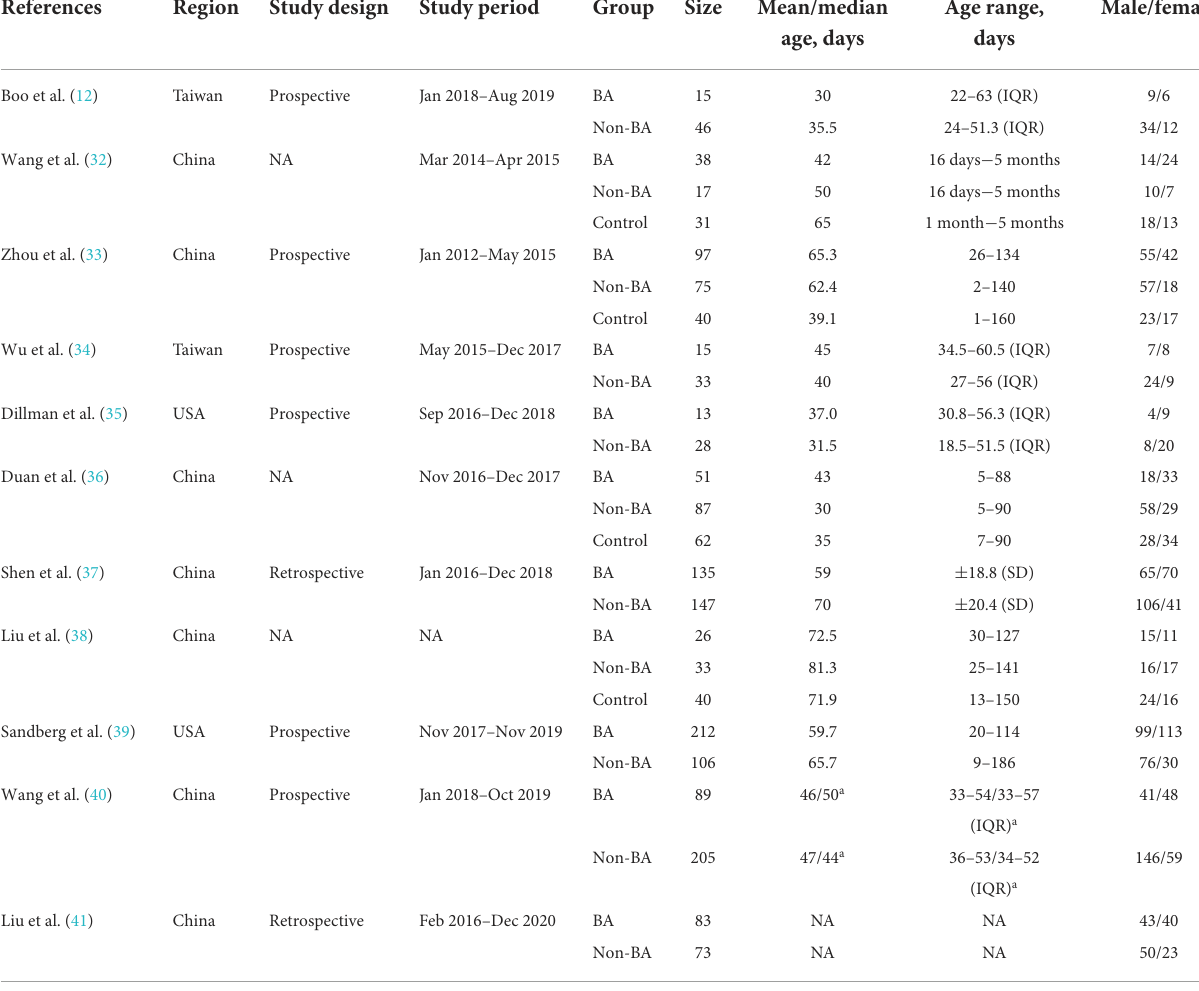
TABLE 1 Basic characteristics of the included